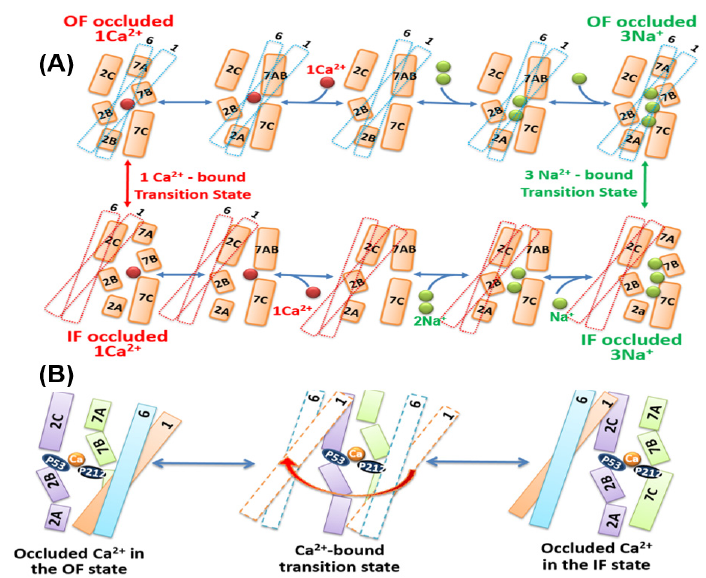
Figure 4. The Ca 2+ - and Na + -bound intermediates during the transport cycle of Na + /Ca 2+ exchange. ( A ) The Na + /Ca 2+ exchange cycle involves separate steps of 3Na + or 1Ca 2+ translocation across the membrane where the transition state (either for Na + or Ca 2+ transport step) is between the occluded states at the extracellular and cytosolic sides. According to this model, the TM1/TM6 undergoes a sliding movement toward performing the OF/IF swapping. Ion interactions with respective sites generate the occluded states either at the extracellular or cytosolic side (green and red spheres represent the Na + and Ca 2+ ions, respectively). Dashed lines refer to the two-helix sliding bundle, TM1/TM6). ( B ) The emerging working hypothesis is that the occupation of the S Ca site plays a critical role in closing the hydrophilic gap between the TM2C (P53) and TM7B (P212) segments, thereby forming a transient hydrophobic patch. The transient hydrophobic environment between TM2 and TM7 can facilitate the sliding movement of the TM1/TM6 bundle on the protein surface, thereby accomplishing the OF/IF